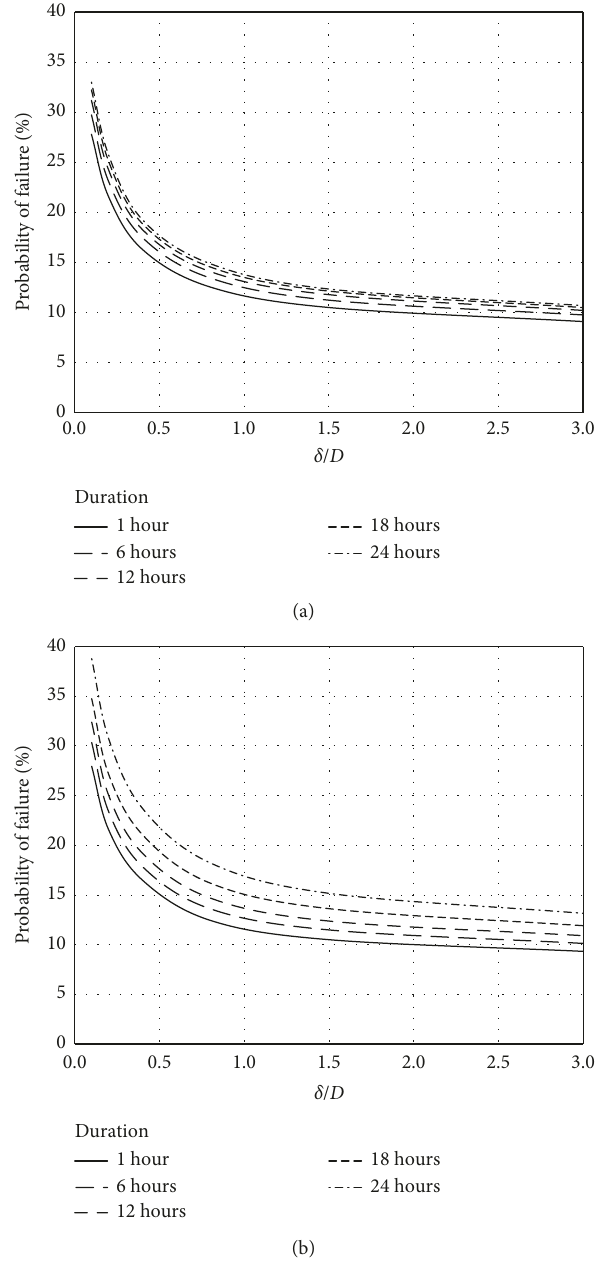
Figure 13: Change in the probability of failure depending on normalized SOF for (a) T r � 2 years and (b) T r � 100